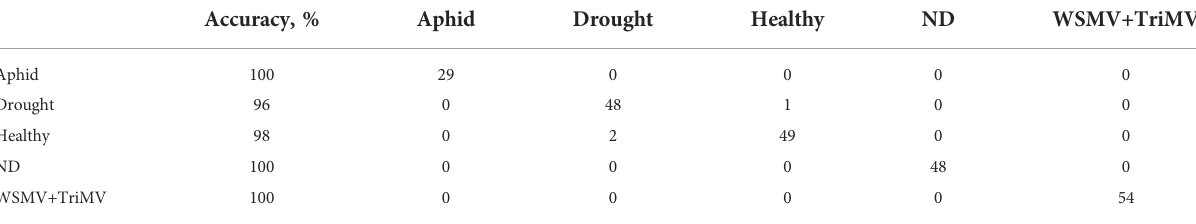
TABLE 2 Accuracy of classi fi cation by PLS-DA wild plant species.